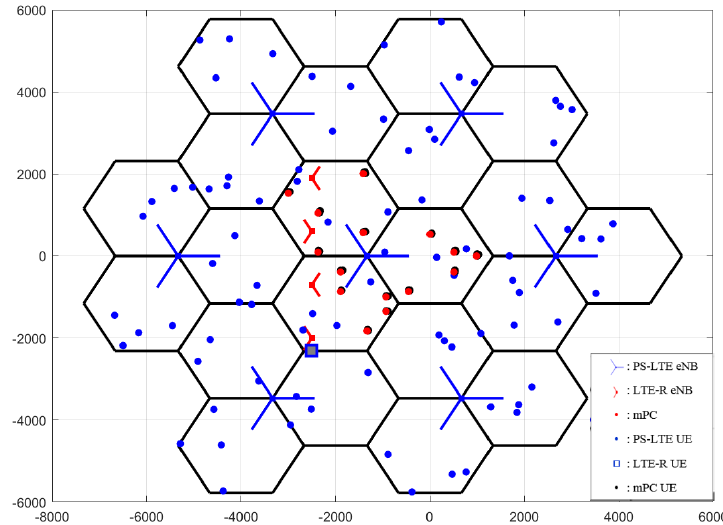
Figure 3. Network layout.